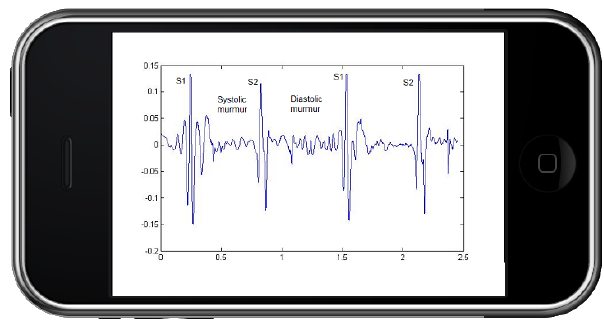
Figure 1: Sample of two-cycle PCG, where compo- nents S1, S2 and heart murmurs are